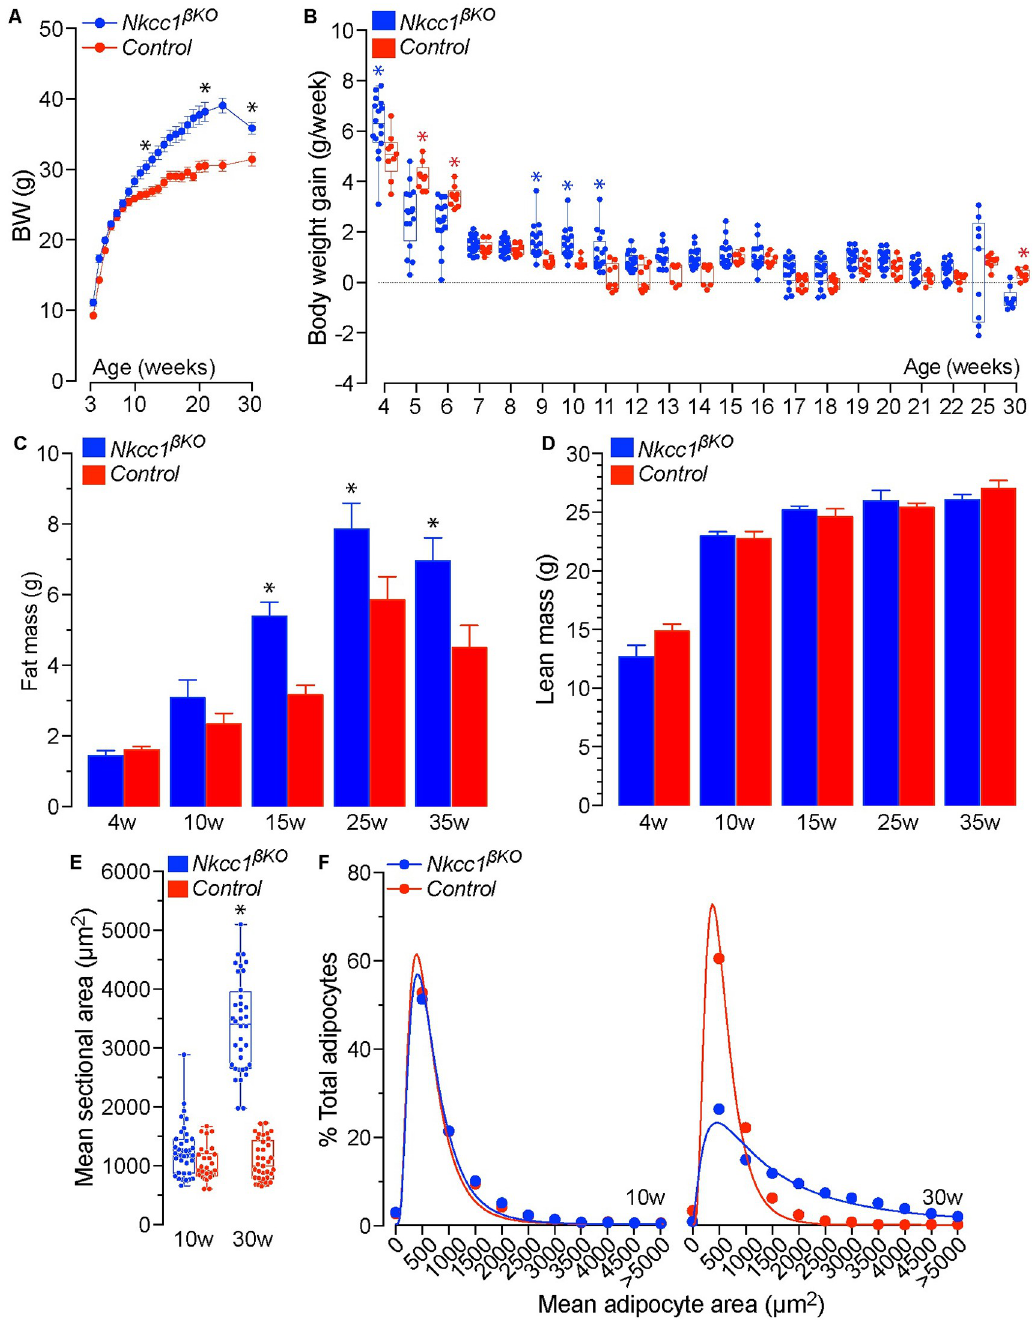
Fig 4. Absolute BW, gain, composition and adipose tissue morphometry of Nkcc1 β KO mice. A . Growth of Nkcc1 β KO and control ( Nkcc1 lox/lox ) mice fed ad libitum a chow diet. Data recorded as net weekly BW mass (g) starting at weaning until mice reached 30w of age. Plotted are the mean ± SEM ( n = 9–16, � p < 0.01). B . Weekly BW gain (g/week) of Nkcc1 β KO and control ( Nkcc1 lox/lox ) mice computed by subtracting BW at a given week age to that of the previous week. Each point represents data from a single mouse ( n = 9–16, � p < 0.01). C, D . Indicated are the mean ± SEM values corresponding to net fat mass (C, g) and lean mass (D, g) of Nkcc1 β KO and control ( Nkcc1 lox/lox ) mice at the indicated ages ( n = 9–16, � p < 0.01). E . Mean cross sectional area ( μ m 2 ) of adipocytes morphometrically determined by analyzing retroperitoneal white fat tissue sections from 10w and 30w old Nkcc1 β KO and control ( Nkcc1 lox/lox ) mice ( n = 3). Each point represents the mean adipocyte area found in a single non- overlapping digital image randomly taken from tissue sections ( n = 6–9) of the indicated genotypes and ages ( � p < 0.001). F . Relative mean adipocyte size distribution computed from the data in